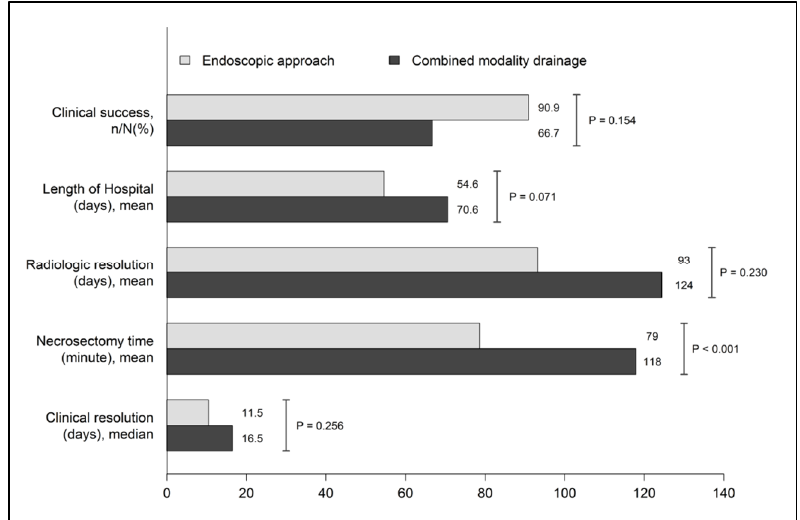
Figure 3. Clinical outcomes between the endoscopic approach and combined modality